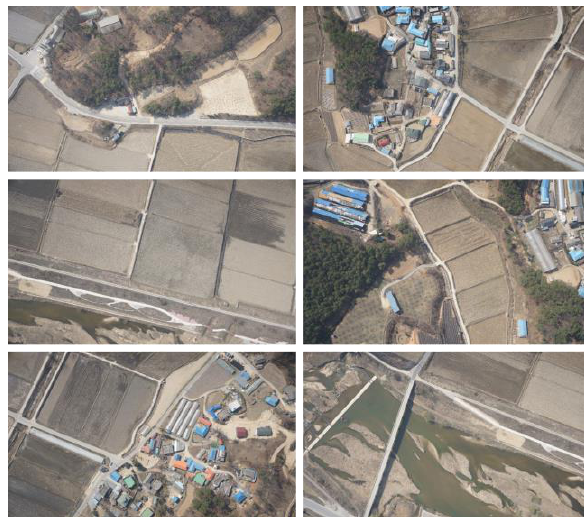
Figure 5. Sample images acquired at the flight altitude of 300 m During the field test, we have a restriction on the flying altitude.